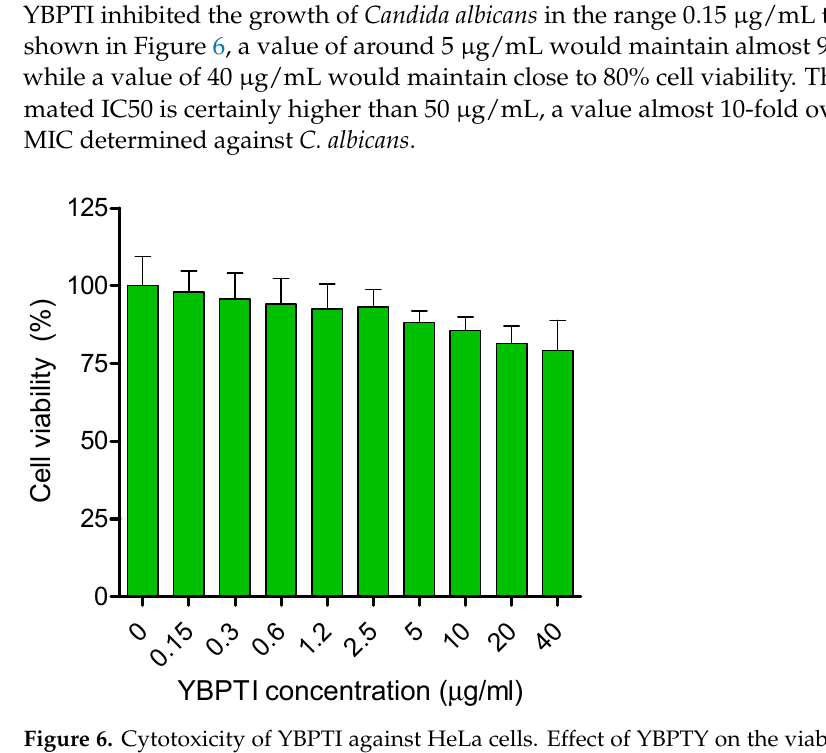
Figure 6. Cytotoxicity of YBPTI against HeLa cells. Effect of YBPTY on the viability of HeLa cells after 24 h incubation .